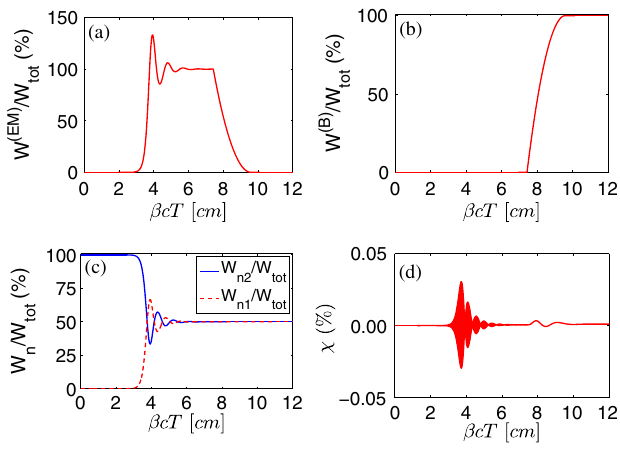
FIG. 12. Energy conservation of the example shown in Fig. 10. Specifically, Fig. 12 shows percentage of initial stored energy transferred to the electromagnetic energy [Fig. 12(a)], electron bunch[Fig.12(b)],andFig.12(c)showspercentageofinitialstored energy remaining in the AM. The fraction of stored energy in the 1 þ ¯ n Þ = 2 =W upper population state level of the AM is W n 2 tot ¼ ð 1 − ¯ n Þ = 2 . Finally, =W and in the lower state level is W n 1 tot ¼ ð Fig. 12(d) shows the numerical error in energy